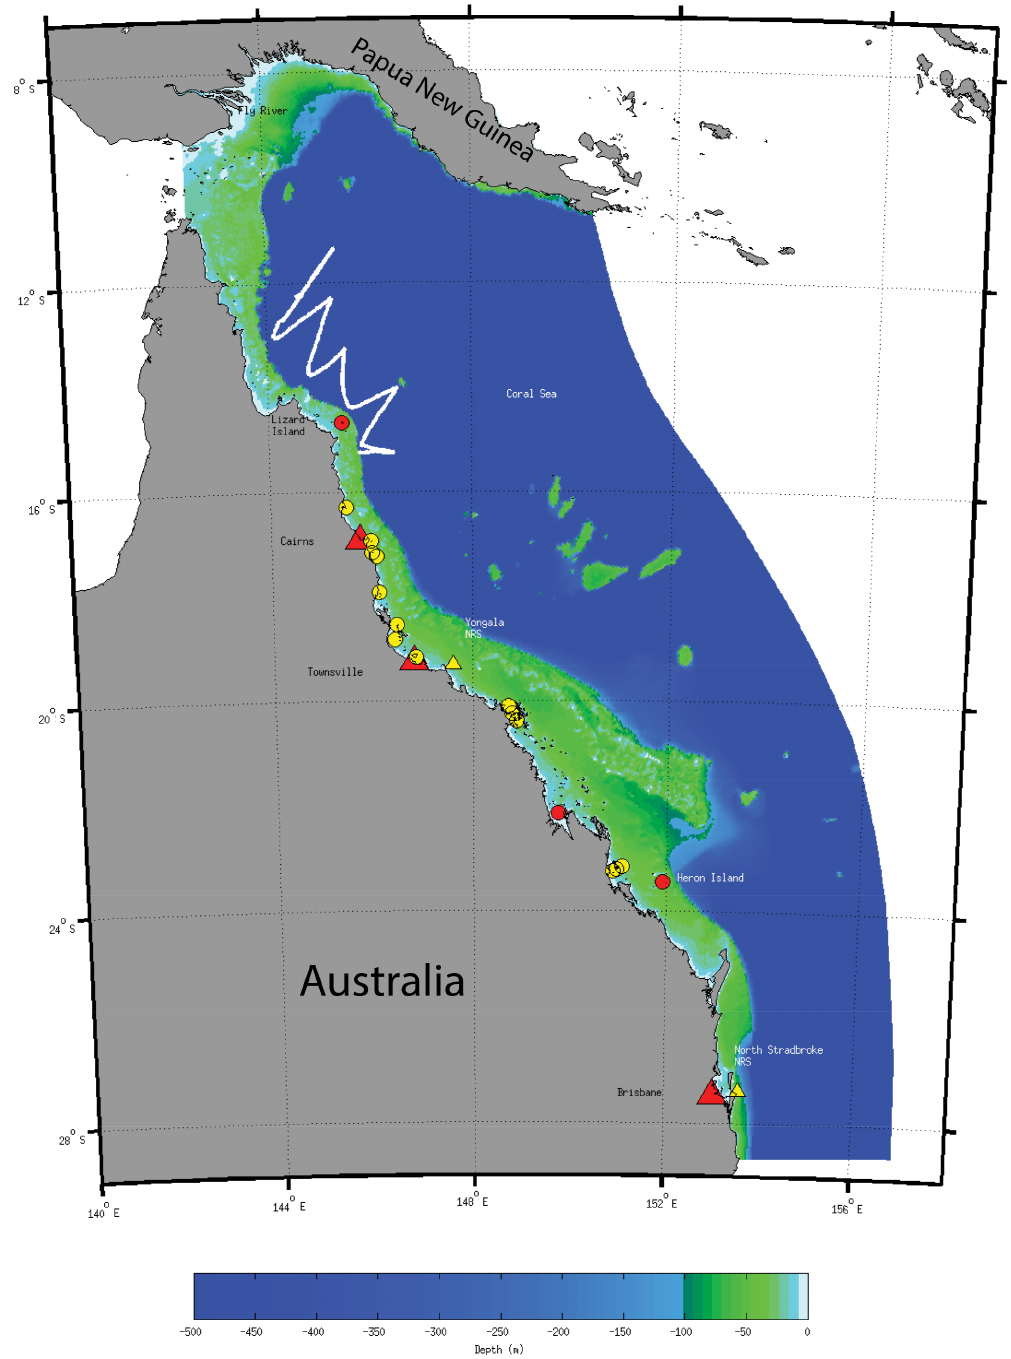
Figure 2. A map of the Great Barrier Reef region, with the colour bar denoting the water depth, markers denoting the population centres (red triangles), IMOS NRS sites (yellow triangles), GBRMPA MMP Water Quality Meters (WQMs; yellow circles) and points of interest referred to in the text (red circles), with the glider track (white line adjacent to Lizard Island). The in situ sampling locations and glider observations are used to assess the data assimilation system